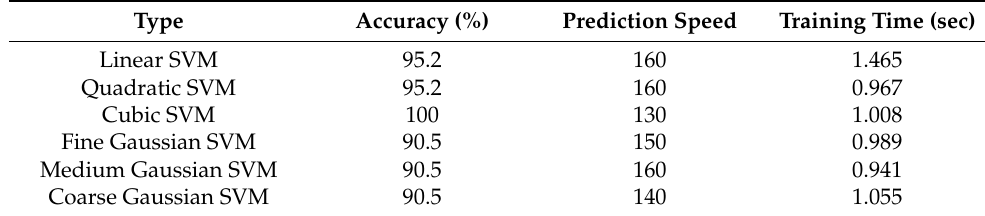
Table 6. SVM 3 DGA classification outcomes.